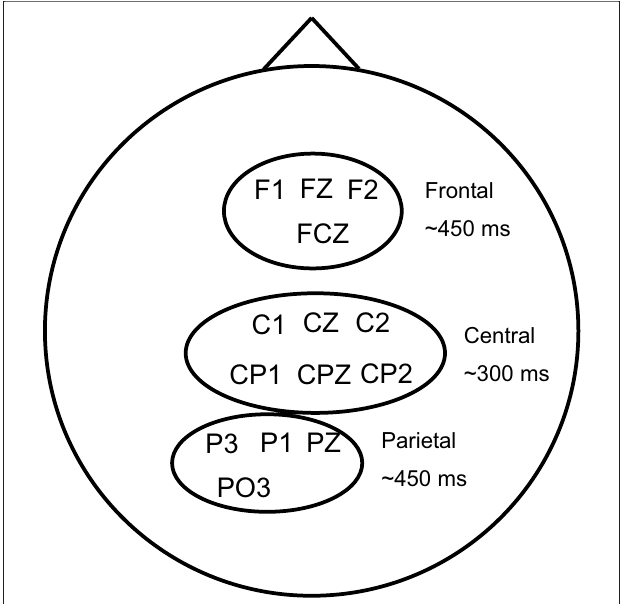
FIGURE 5 | Channels and latencies used for identifi cation of the three electrode clusters. Latencies are approximate; they were ultimately determined by RT (see Figure 6 ).